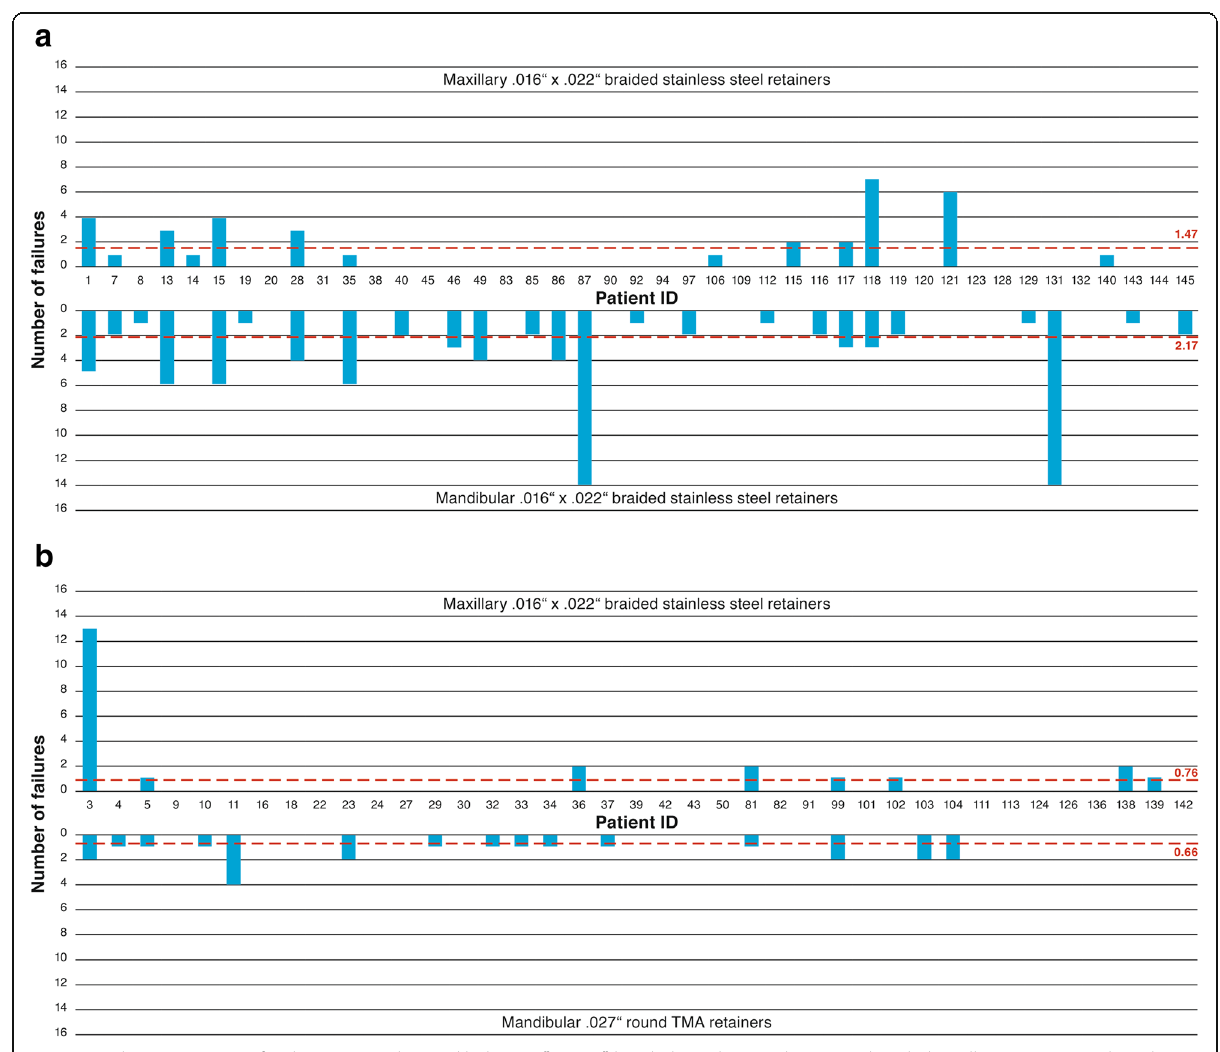
Fig. 5 a Failures per patient for the group with mandibular .016 ″ × .022 ″ braided stainless steel retainers bonded to all six anterior teeth and maxillary .016 ″ × .022 ″ braided stainless steel retainers bonded to all four anterior teeth. b Failures per patient for the group with mandibular .027 ″ round TMA retainers bonded only to the canines and maxillary .016 ″ × .022 ″ braided stainless steel retainers bonded to all four anterior